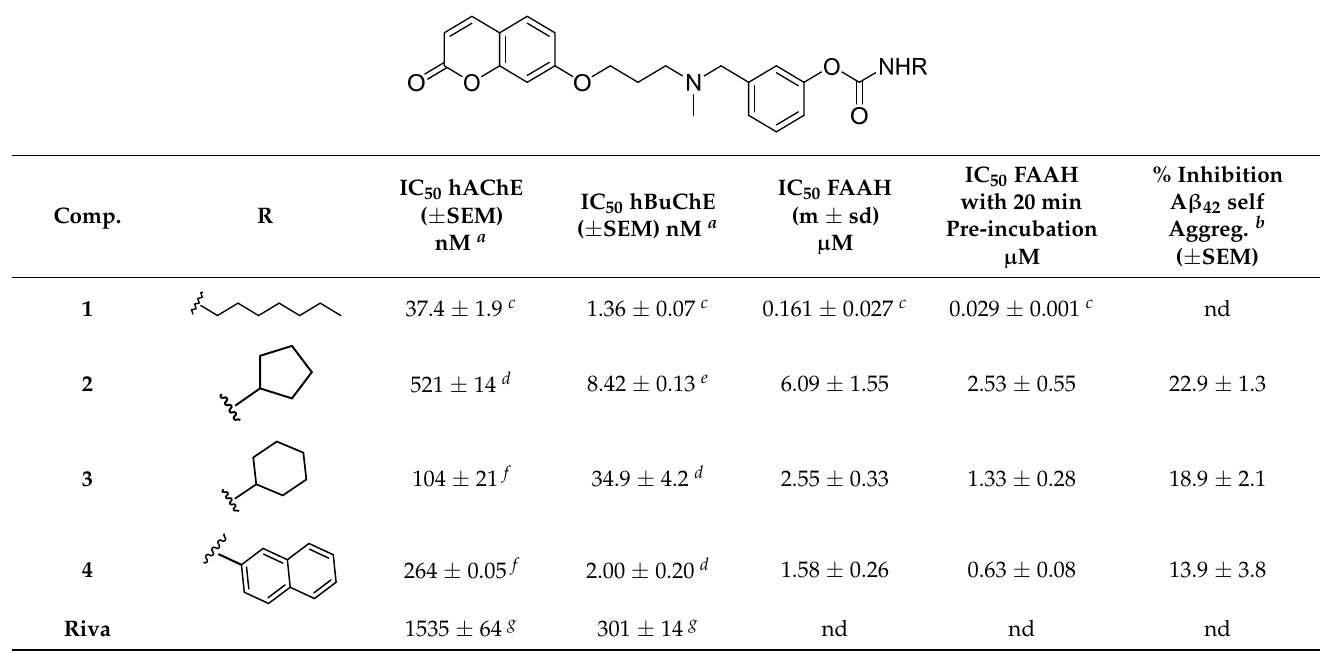
a Human recombinant AChE and BuChE from human serum were used. IC 50 values represent the concentration of inhibitor required to decrease enzyme activity by 50% and are the mean of two/three independent measurements, each performed in duplicate. SEM = standard error of the mean; b [A β 42] = [inhibitor] = 50 µM; c Data from reference [20]; d Incubation time 60